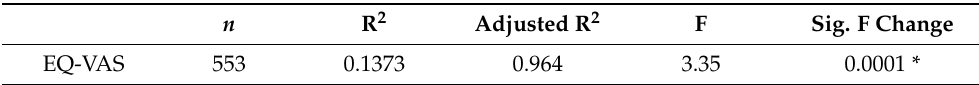
Table 4. Linear multivariate regression model results.